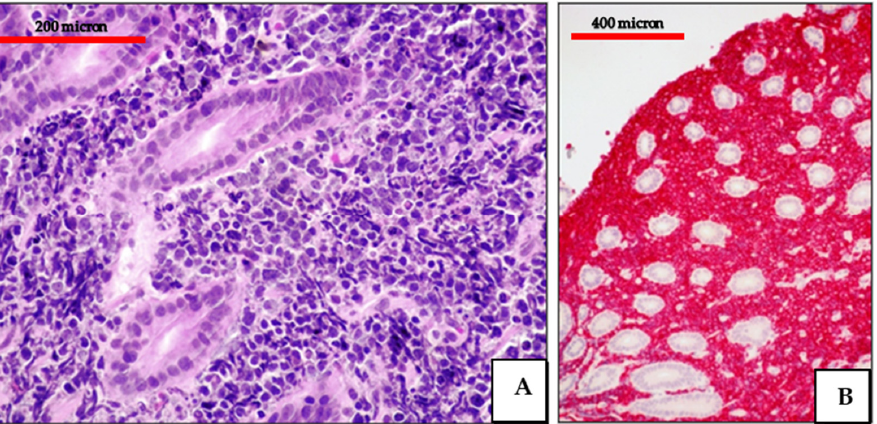
Figure 10. ( A ) BL of the duodenum: lymphoid infiltrate within the duodenal mucosa (Hematoxylin and eosin, magnification 200 × ; original image from Prof Ascani); ( B ) BL: diffuse CD20 positivity confirming the B-cell phenotype of the lymphoid cells (immunostaining, Ventana immunostainer, magnification 100X; original image from Prof Ascani).